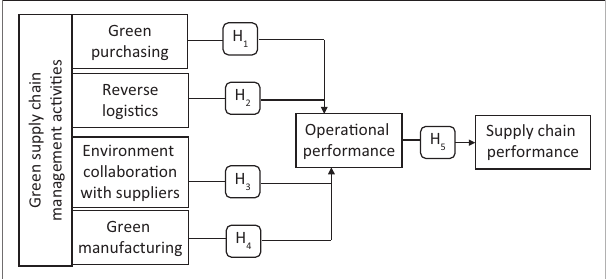
FIGURE 1: Conceptual framework linking green supply chain management activities